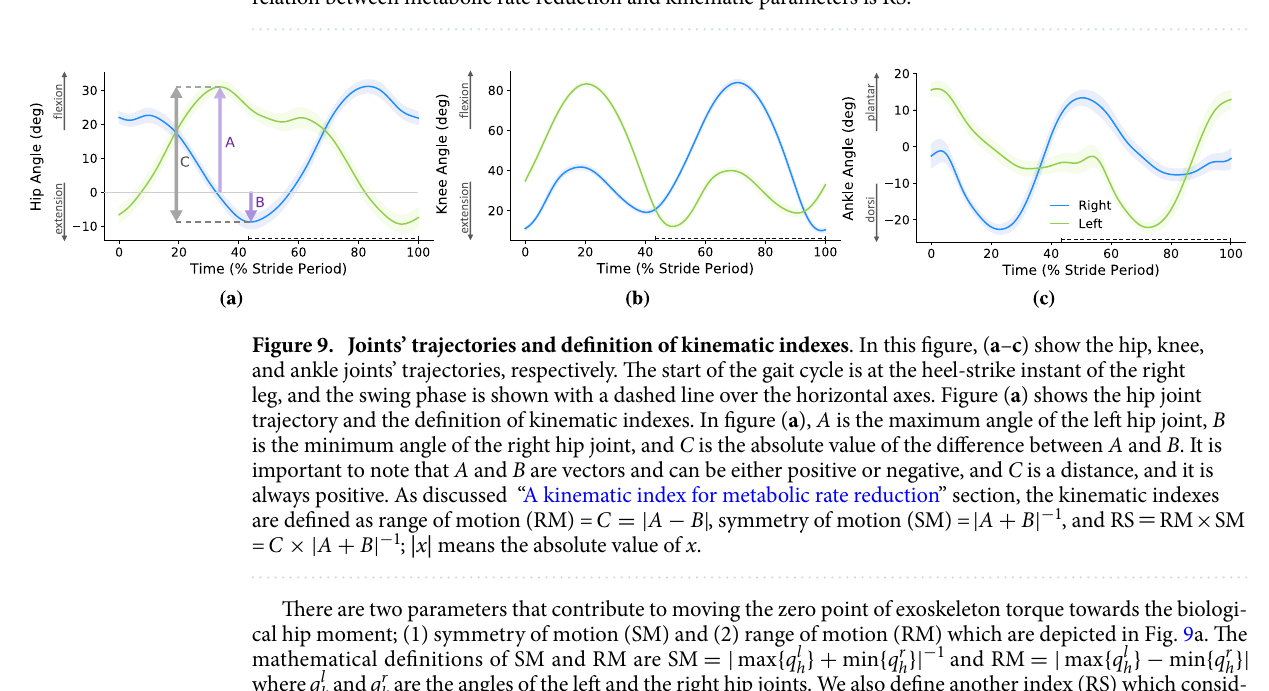
Figure 8. Kinematic analysis . ( a , b ) compare the normalized biological hip torques, hip joints’ angles, and normalized assistive torques for the subjects with the highest and lowest metabolic rate reductions. The start of the gait cycle is at the heel-strike instant of the right leg, and the torque profiles in ( a ) and ( b ) are for the right leg. The swing phase is shown with a dashed line over the horizontal axes. Gray areas define the difference between the zero points of the biological hip torque and assistive torque. As it is clear, gray areas are much narrower for the subject with the highest metabolic rate reduction. ( c – e ) Compare three different defined kinematic indexes for estimating the metabolic rate reduction. In figures ( c – e ), each color indicates one subject. As can be seen, P value and goodness of fit are improved from RM, SM, and RS = RM × SM, respectively. In ( c ), the linear regression (pink line) cannot properly estimate the metabolic rate such that there is an outlier (pink star) in this figure; by excluding the outliers based on the Jack-knife criterion (significance level = 0.05 ), the goodness of fit of the linear regression (gray line) is improved. However, in ( d , e ), the outlier approaches to the linear regression and the goodness of fit improves further. Accordingly, the best index for having a good linear relation between metabolic rate reduction and kinematic parameters is RS.